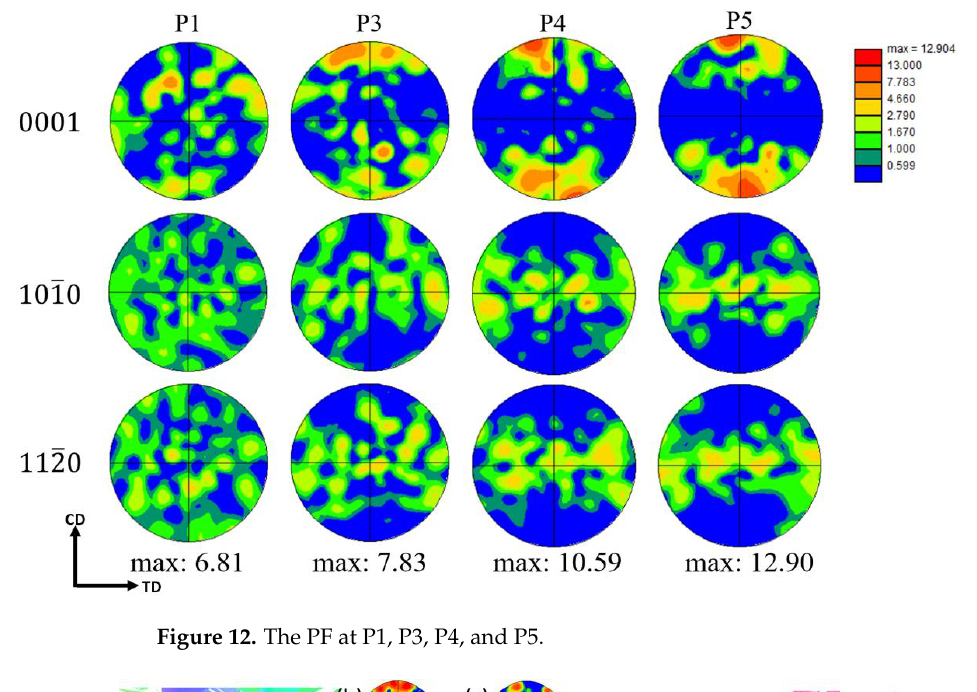
Figure 12. The PF at P1, P3, P4, and P5.